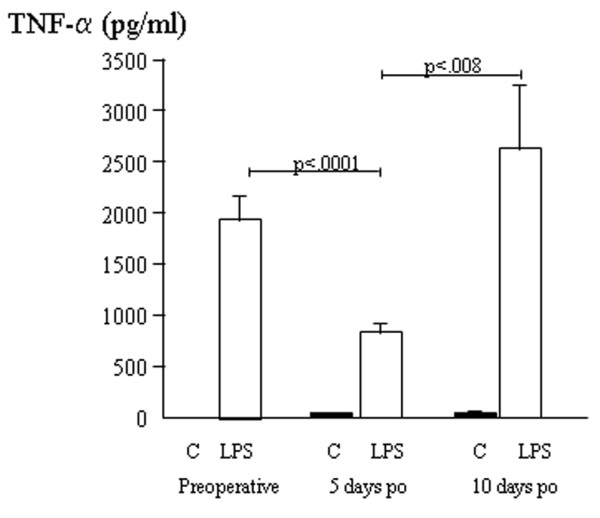
Ex vivo production of tumor necrosis factor-α. Preoperative and postoperative (po) tumor necrosis factor-α (TNF-α) levels in whole blood culture supernatant. Values are expressed as means and SEM (error bars). TNF-α production was significantly increased after stimulation with lipopolysaccharide (LPS; white), in comparison with the unstimulated control (C; black) at all time points. In comparison with preoperative levels, TNF-α production after stimulation with LPS significantly decreased 5 days after operation (P < 0.001) but again reached preoperative levels 10 days after operation.